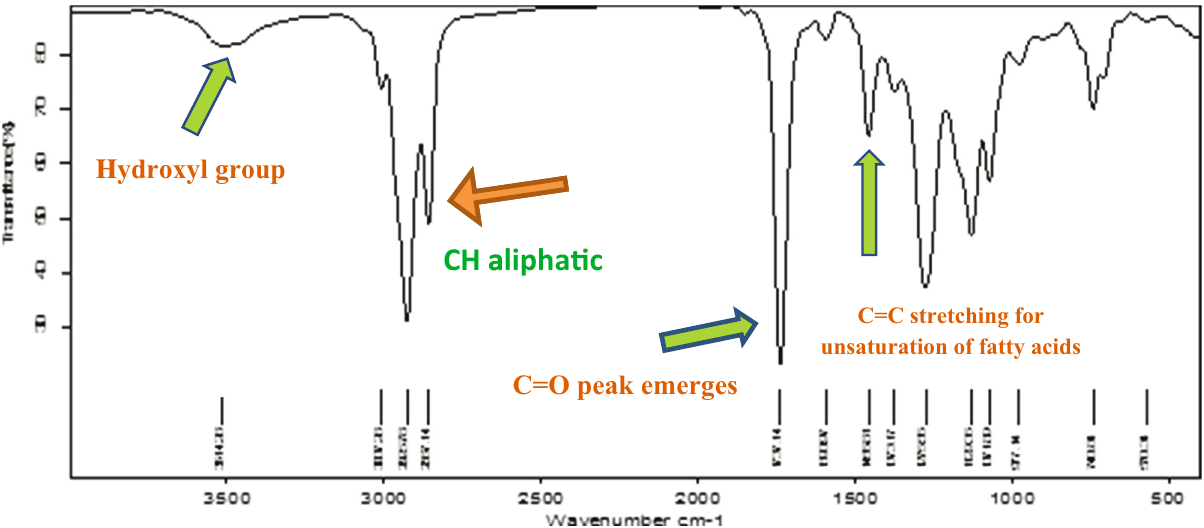
Figure 1: IR spectra of the modi fi ed alkyd resin.